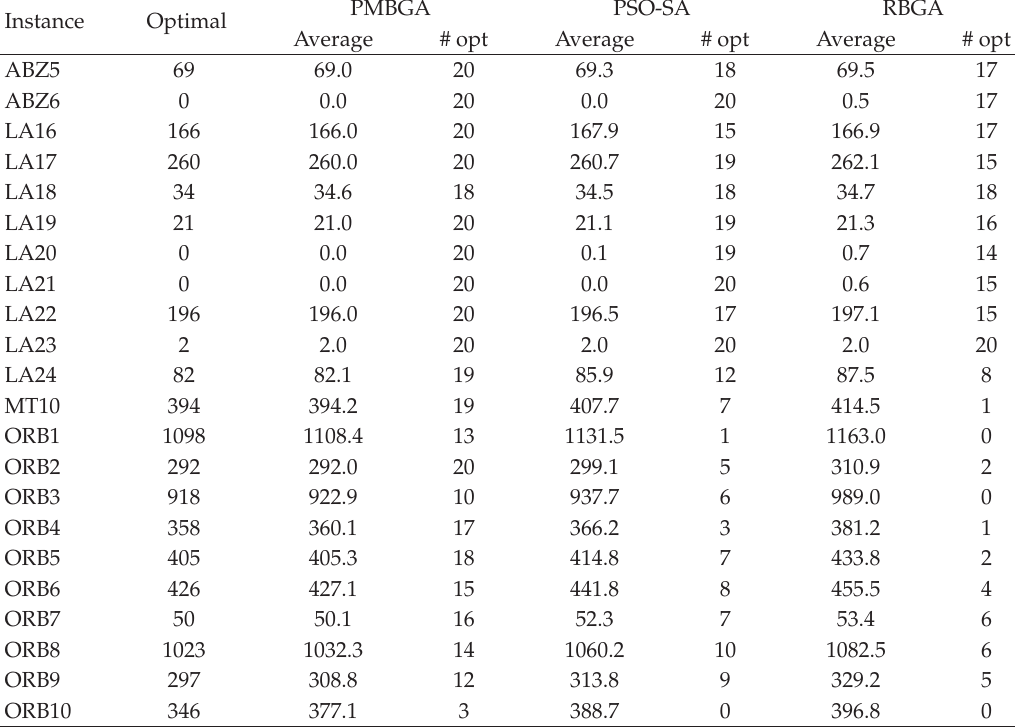
Table 2: The computational results and comparisons under f (cid:9) 1 .